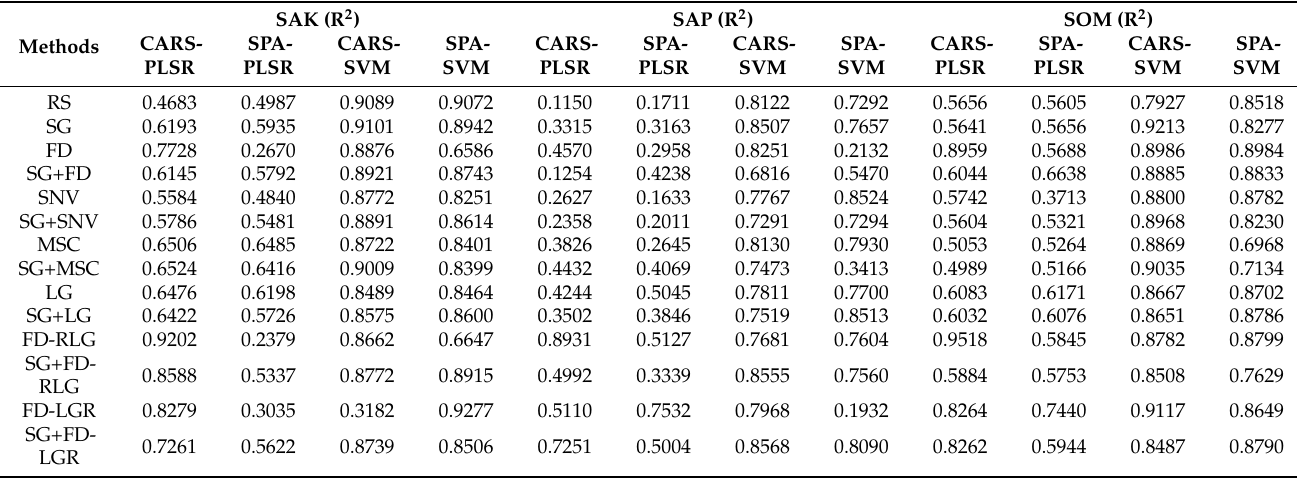
Table 2. The performance (R 2 ) of the PLSR and SVM models with the feature wavelengths selected by using CARS and the SPA under 14 spectral